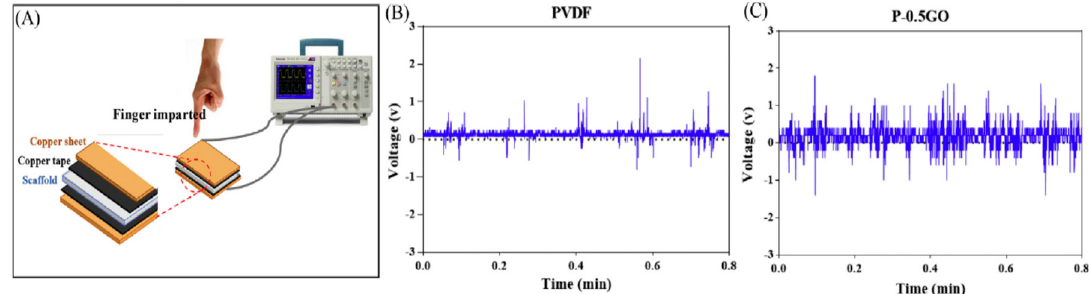
Figure 8. ( A ) Schematic of piezoelectricity measurement. Output voltage generation from representative ( B ) PVDF and ( C ) PVDF/0.5 wt% GO scaffolds. Reproduced with permission from [81], published by Elsevier, 2019.